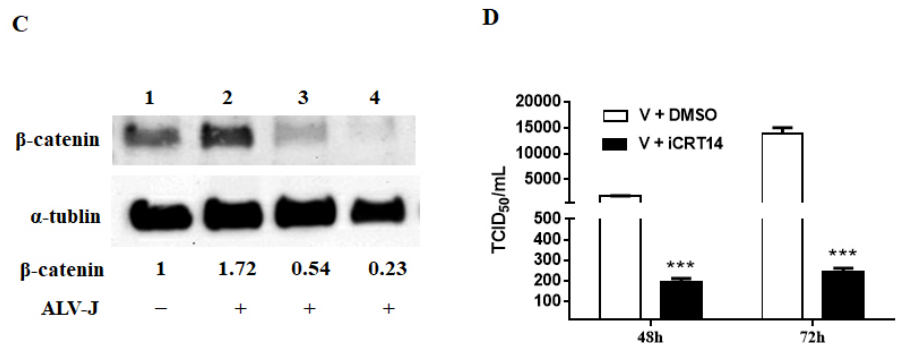
Figure 4. iCRT14 decreased ALV-J replication in CEF cells. ( A ) After 72 h of incubation, effects of